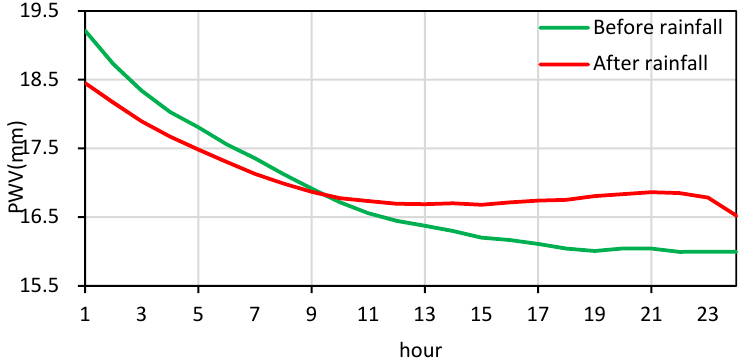
Figure 6. PWV comprehensive statistical line chart within 24 h before and after rainfall. The blue line indicates the change in PWV 24 h before rainfall, and the red line indicates after. The PWV changes 24 h before and after rainfall were statistically analysed, and their range, variance and standard deviation were calculated (Table 2). It could be seen from the table that the variance of PWV in the 10 h before the rainfall changed gr eatly, and in- creased fro m 81.7 to 101.1, and then it was basically stable between 82 and 85, indicating that the PWV in the 10 h before the rainfall changes violently and unevenly. Within 23 h after the rainfall, the variance of PWV basically remained between 97 and 100, indicating